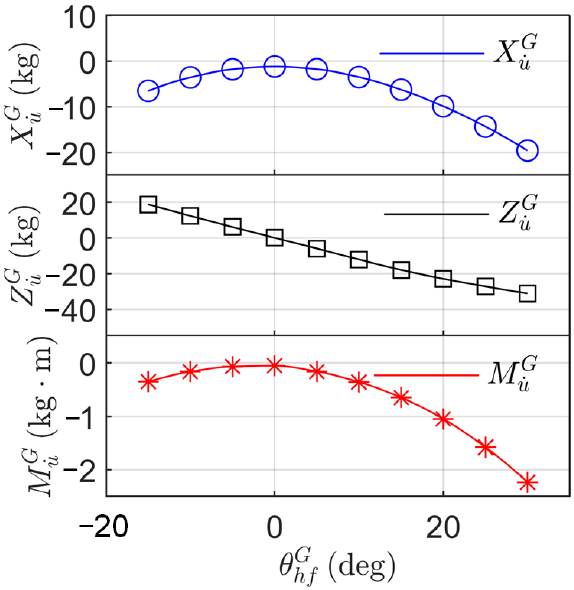
. u dependent added mass Figure 11. The results of u  dependent added mass coefficients. Figure 11. The results of Figure 11. The results of u  dependent added mass coefficients.